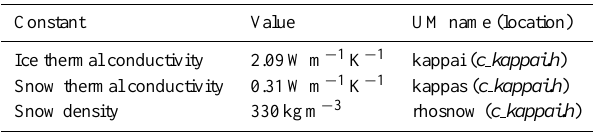
Table 2f. Table of temporary variables as used in the coupling op- erations described in Tables 2c and e.